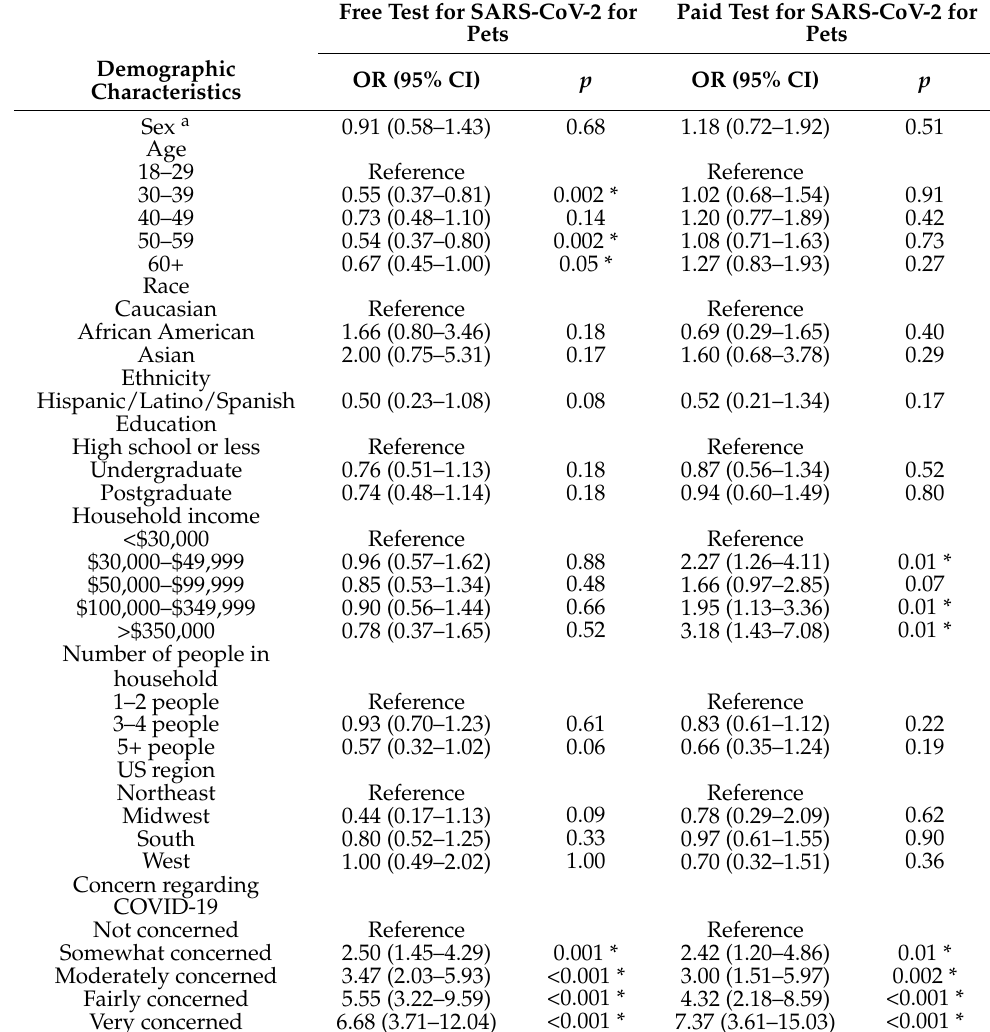
Table 5. Logistic regression models describing associations between demographic characteristics and respondent’s willingness to have their pets tested for